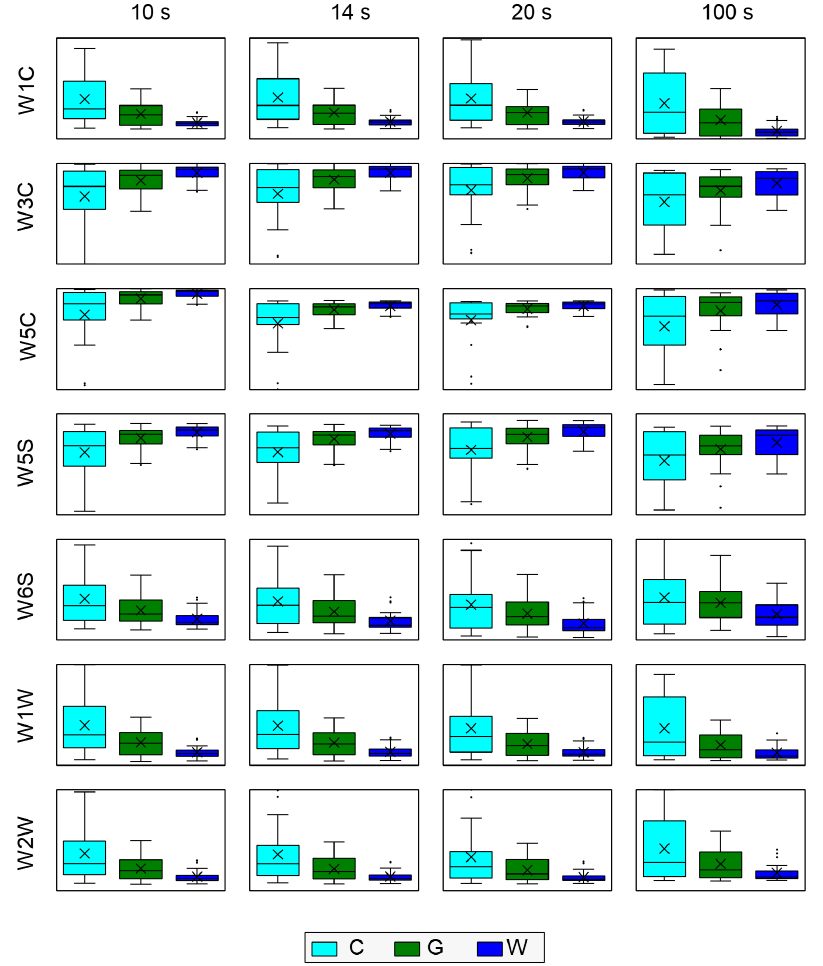
Figure 12. Distribution of modeling feature extracted from the sensor response characteristics for measured samples categories. Data for selected sensors at the selected moment of measurements are indicated in the grid labels. The box spans the 1st to 3rd quantile of data. The whiskers span 1.5 IQR (IQR-inter quantile range). The horizontal line inside the box represents the median, and the × inside boxes represents the